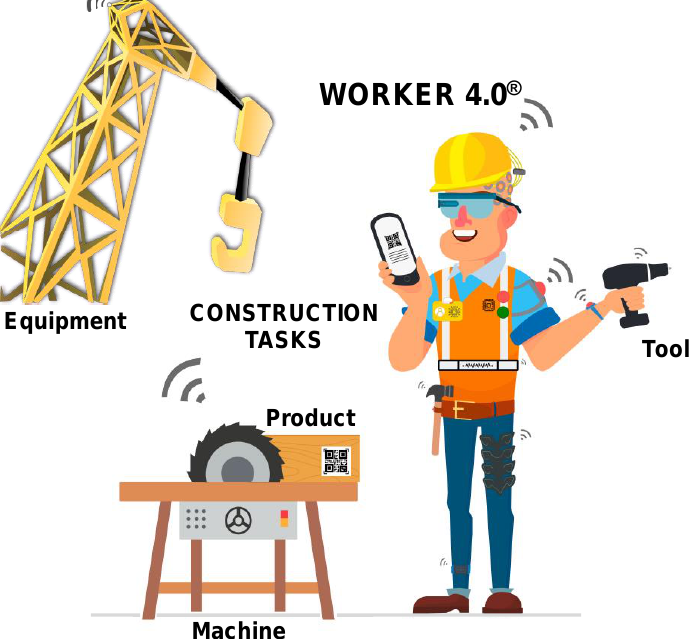
Figure 1. Construction tasks: workers + products + equipment.